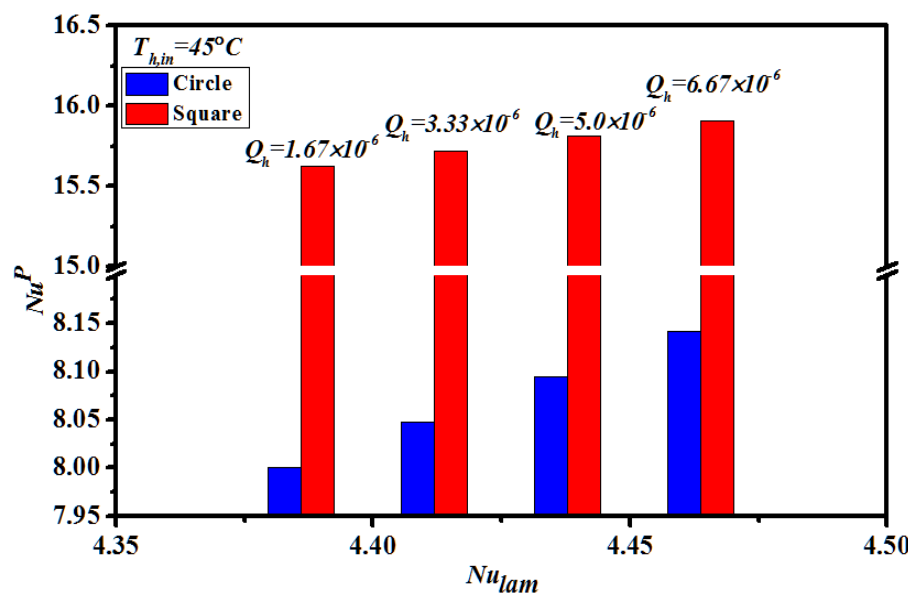
Figure 10. Comparisons of theoretical Nusselt numbers for the channels with inserting two geometric shapes and Type A of turbulence promoters.